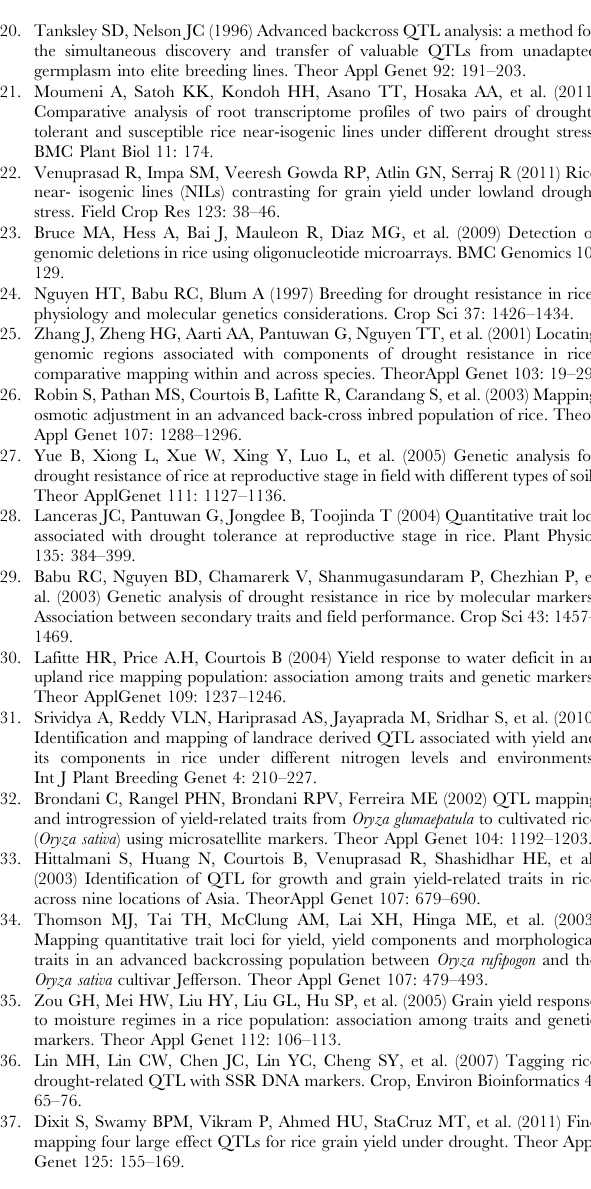
Table S4 Regions of aggregation of differentially ex- pressed genes from the re-analyzed transcriptome dataset. Table S5 Enriched Gramene QTL categories of the